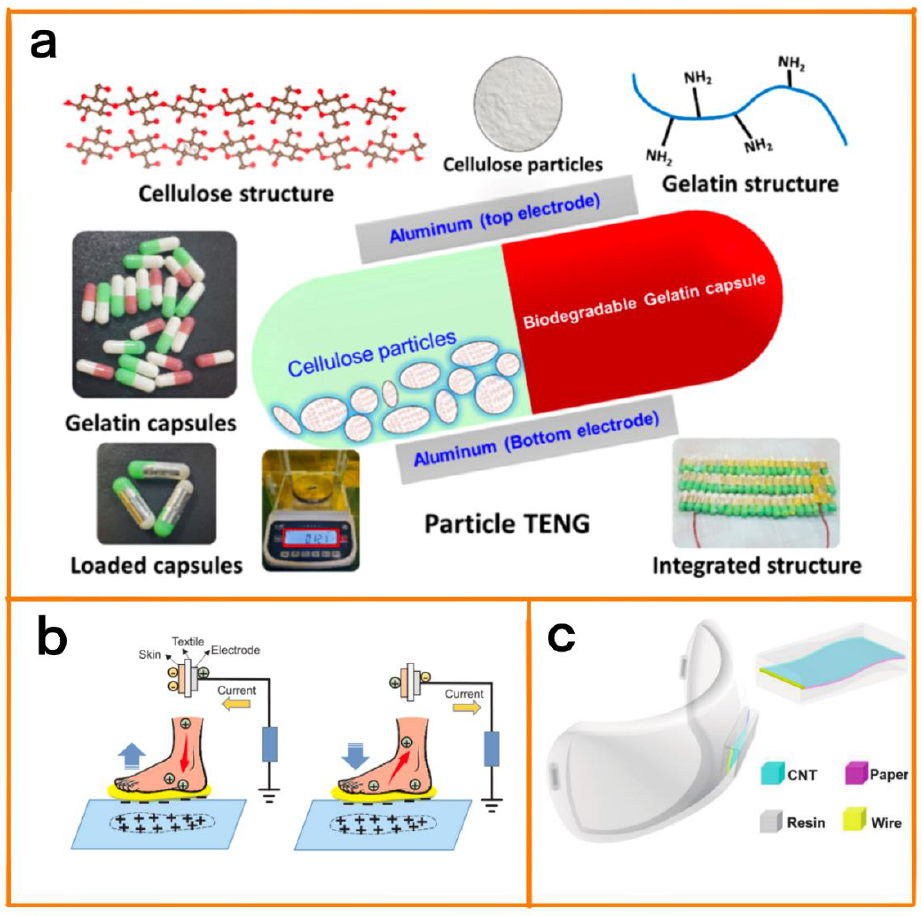
Figure 3. ( a ) Design scheme and schematic diagram of the rapid degradation of P-TENGs showing the tiny cellulose particles and gelatin capsules. Reprinted with permission from [41]. 2022, Elsevier. ( b ) Schematic diagram of the working mechanism of the single-electrode mode triboelectric system. Reprinted with permission from [42]. 2019, Elsevier. ( c ) Structure diagram of the 3D-printed breath- driven TENG. Reprinted with permission from [43]. 2022, Springer Nature.